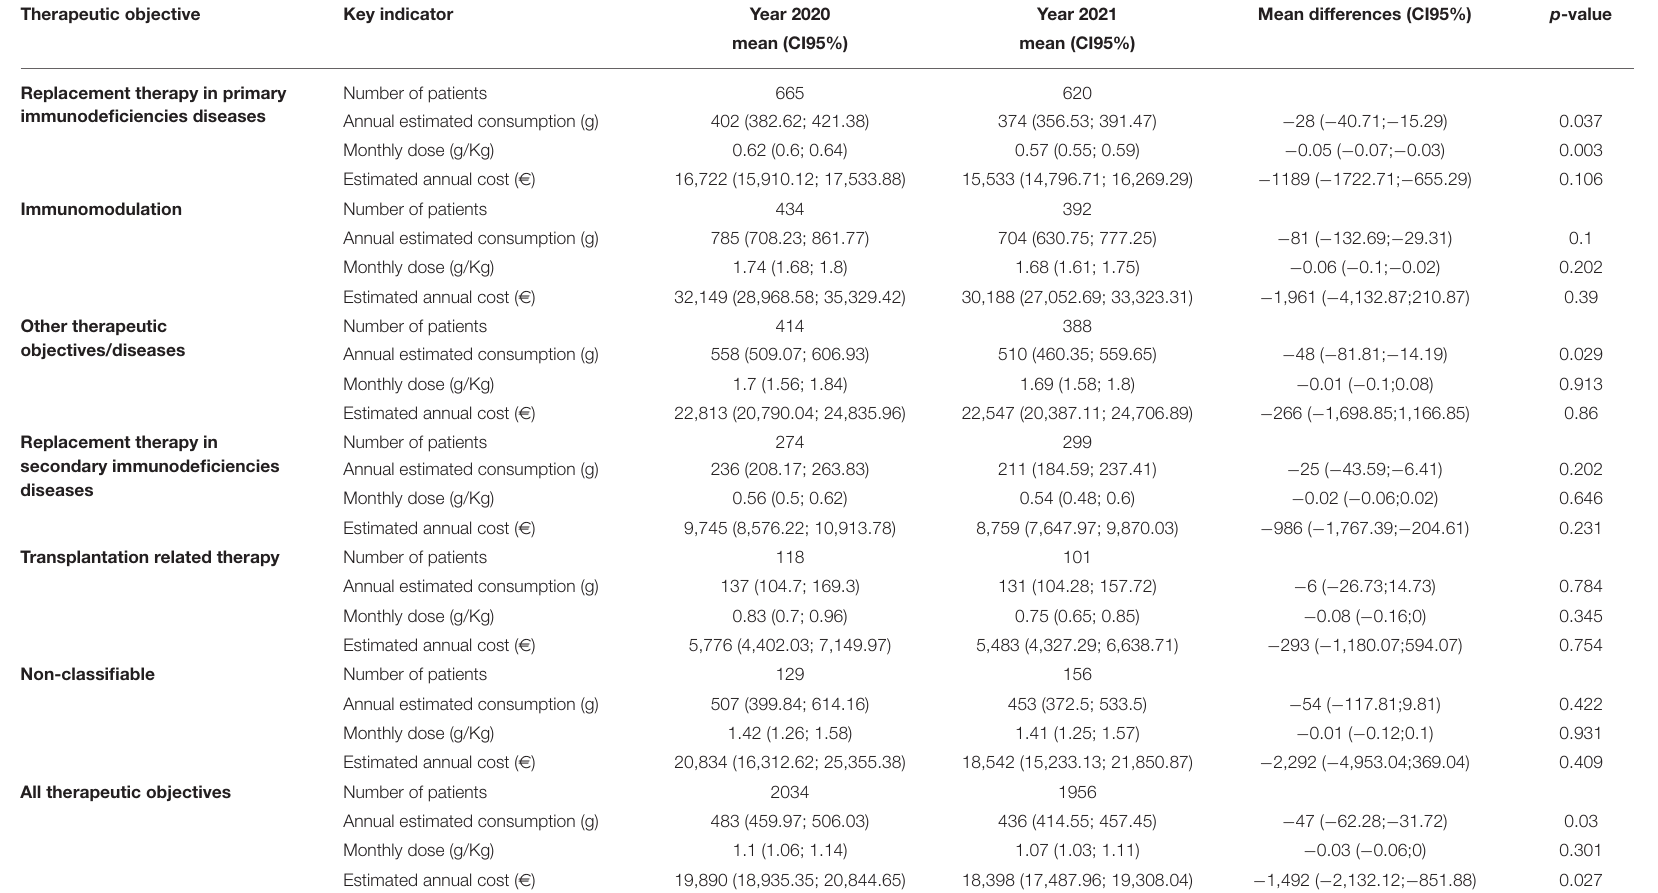
TABLE 2 | Main differences between 2020 and 2021 trends in IgG consumption. Therapeutic